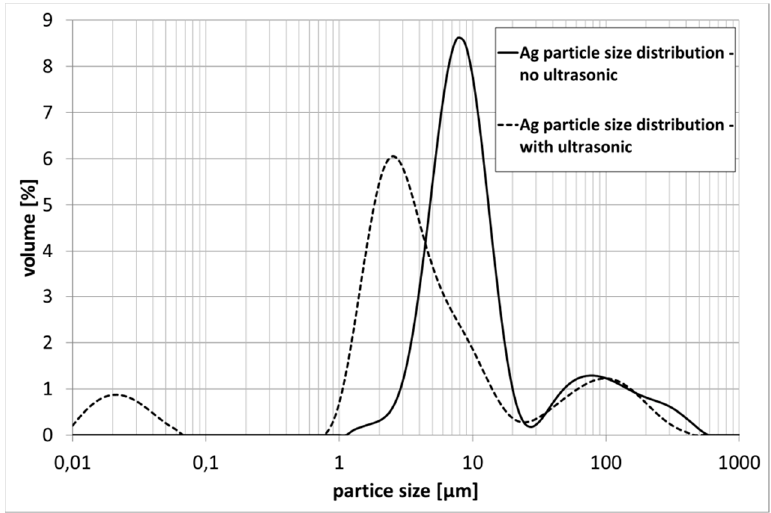
Figure 2. Particle size distribution of silver suspension—with and without ultrasonic treatment.